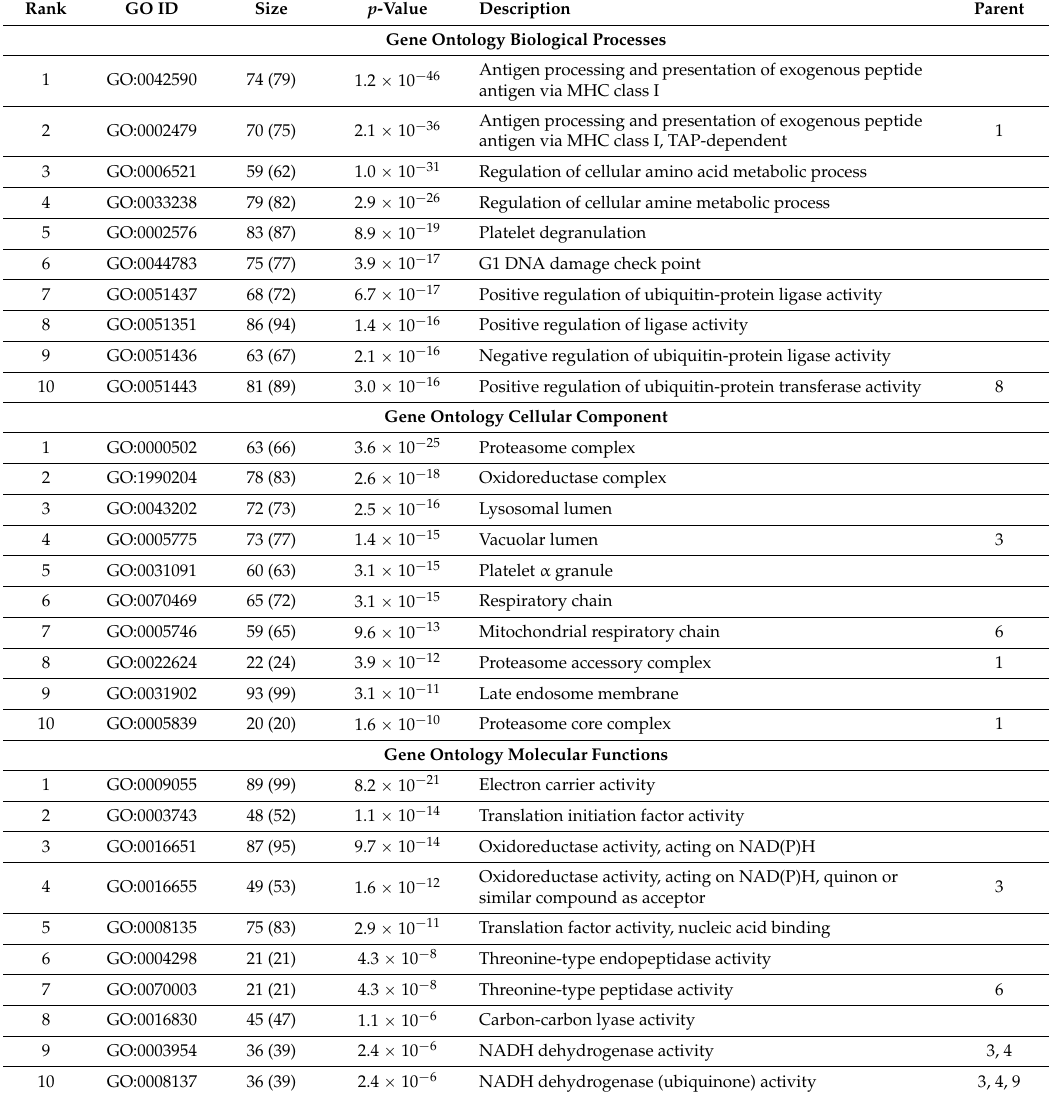
Table 2. Gene Ontology (GO) gene sets most strongly affected upon treatment with a high dose of diclofenac (1000 µ M